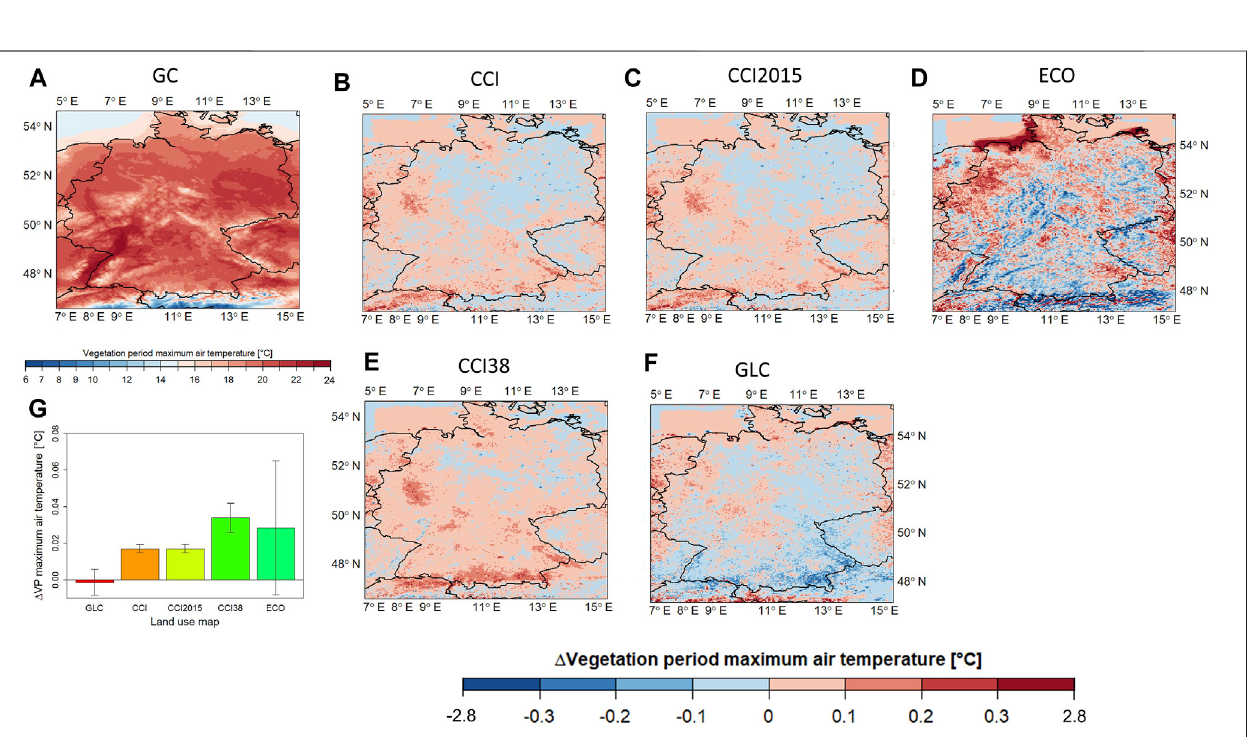
FIGURE 8 | Distribution of daily vegetation period maximum temperature climatology (2002 – 2011) for the control simulation based on GlobCover 2009 (A) , the difference between the simulation based on CCI and the control simulation (B) , the difference between the simulation based on CCI2015 and the control simulation (C) , thedifferencebetweenthesimulationbasedonECOandthecontrolsimulation (D) ,thedifferencebetweenthesimulationbasedonCCI38andthecontrolsimulation (E) , and the difference between the simulation based on GLC2000 and the control simulation (F) . Domain averaged differences in vegetation period maximum temperature for GLC, CCI, CCI 2015, CCI38, and ECO compared with the control simulation between 2002 and 2011 (G) . Please see Table 1 for abbreviations. Grids with an overlaid black circle indicate statistically signi fi cant (at the 95th percentile level using the t -test) differences.